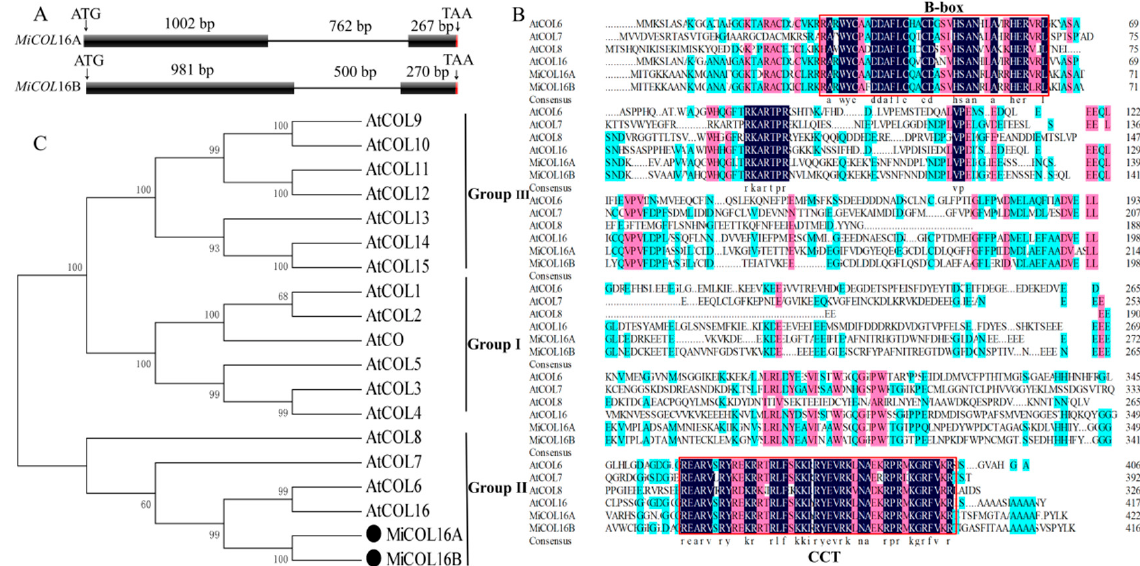
Figure 1. Sequence analysis of MiCOL16A and MiCOL16B . ( A ) Genomic structures of MiCOL16A and MiCOL16B . Exons are represented by black squares, and introns are represented by black lines. The numbers indicate the lengths of the corresponding regions. ( B ) Alignment of the predicted amino acid sequences of AtCOL6–8 and AtCOL16 in Arabidopsis and of MiCOL16A and MiCOL16B in mango. The conserved CCT and B-box domain regions are indicated with red boxes. The dark color indicates that the amino acids are 100% conserved. The genes and their accession numbers are shown in Supplementary Table S1. ( C ) Phylogenetic relationship of CO/COL proteins in Arabidopsis and mango. MiCOL16A and MiCOL16B are represented by black solid circles.